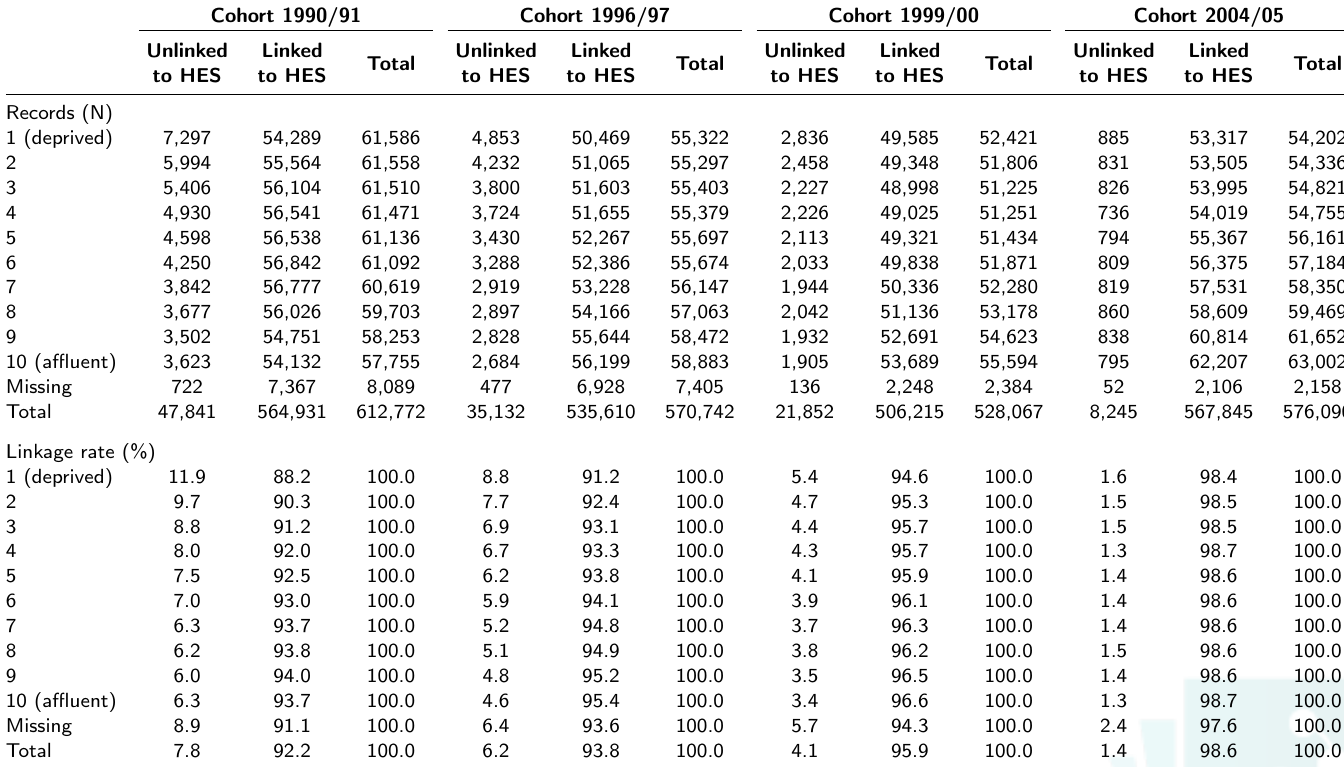
Supplementary Table 8.4: Linking rate by IDACI deciles and